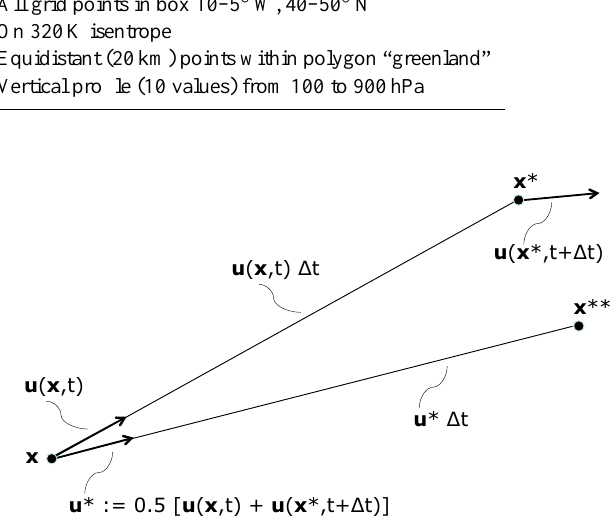
Figure 3. Schematic representation of the iterative Eulerian time step used in LAGRANTO. The air parcel’s position at time t is given as x . The velocity field at this position is u ( x ) . Based on the posi- tion, the velocity and the time step, a new air parcel position can be calculated with a simple Euler forward step: x ∗ = x + (cid:49)t · u ( x ,t) . However, a simple Euler forward step is not numerically accurate. Therefore, in a next iteration a new velocity u ∗ is computed as the average of the velocities at the initial position and at the forward projected position. A new air parcel position x ∗∗ is then calculated based on this refined guess of the velocity. In LAGRANTO, three such iterative steps are repeated to obtain the final new position of the air